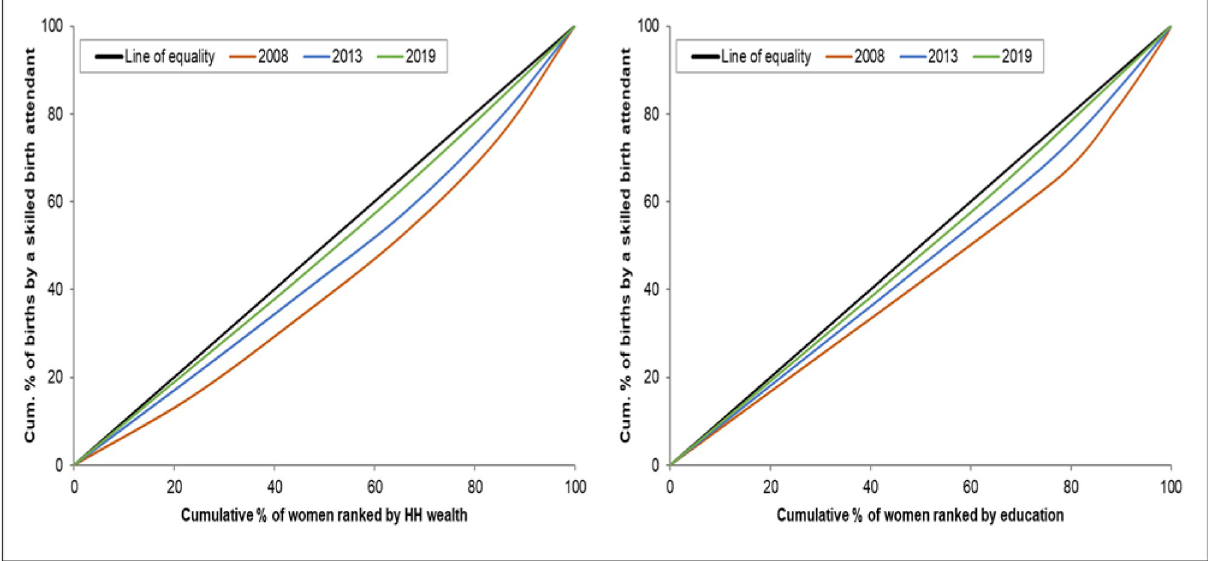
Fig 4. Concentration curves showing wealth-and-education-based inequality in the use of skilled birth attendants in Sierra Leone, 2008, 2013 and 2019.